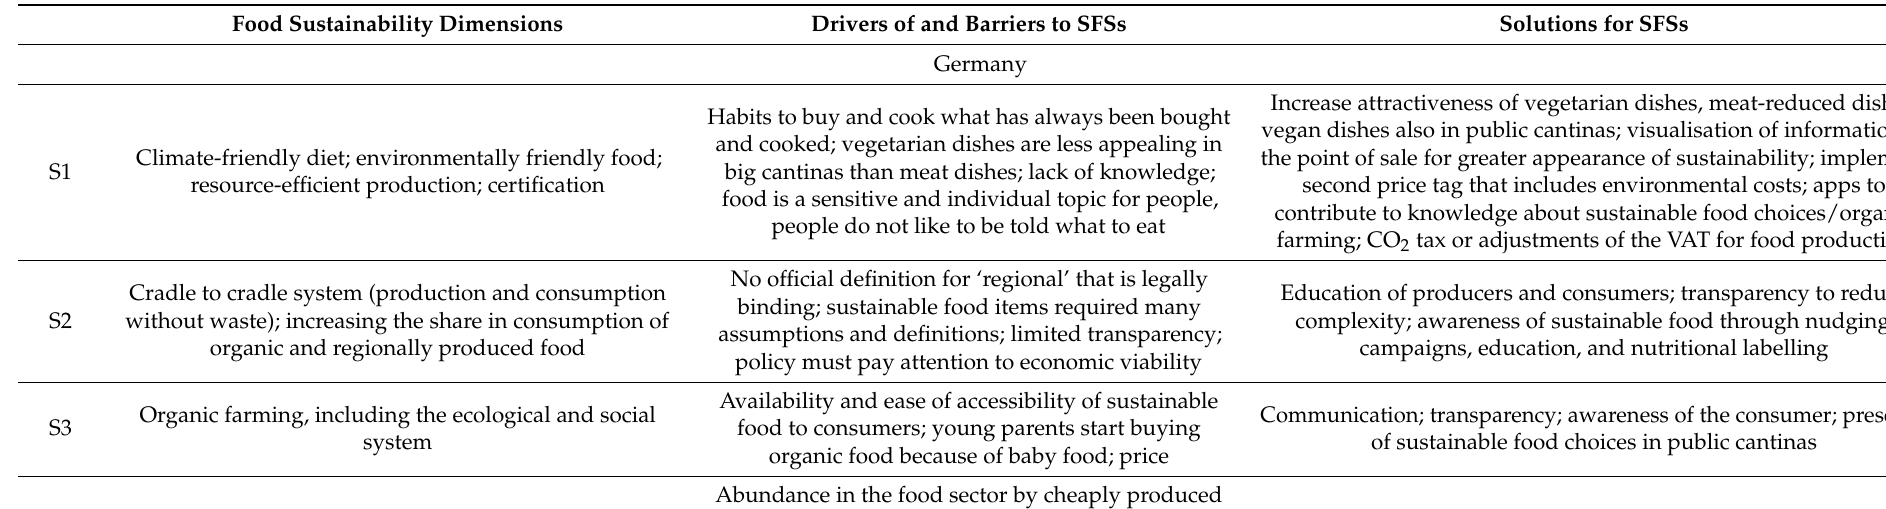
Table A3. Relevant sustainability dimensions, drivers, barriers, and solutions related to SFSs highlighted by interviewed stakeholders according to qualitative content